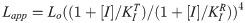
Successful application of global fitting analysis of hemoglobin physiological datasets.(A) Global fitting analysis of the human hemoglobin pH, CO2 and 2,3-BPG physiological datasets using the traditional form of the MWC equation. Source data is indicated above each panel. (B) Dependence of observed (open circles) and calculated (filled circles) Hill values of each dataset on effector concentration. (C) Dependence of the apparent L values of each physiological dataset on effector concentration. Solid curves represent the results of curve fitting to the MWC-derived equation Lapp=Lo((1+[I]/KIT)/(1+[I]/KIR))4, assuming non-exclusive binding of the inhibitor effector (I) to both the T and R MWC conformations [11,12]. In the case of organophosphate inhibitors, a power of one was used in the above equation, as only one site is available to BPG for binding to hemoglobin.